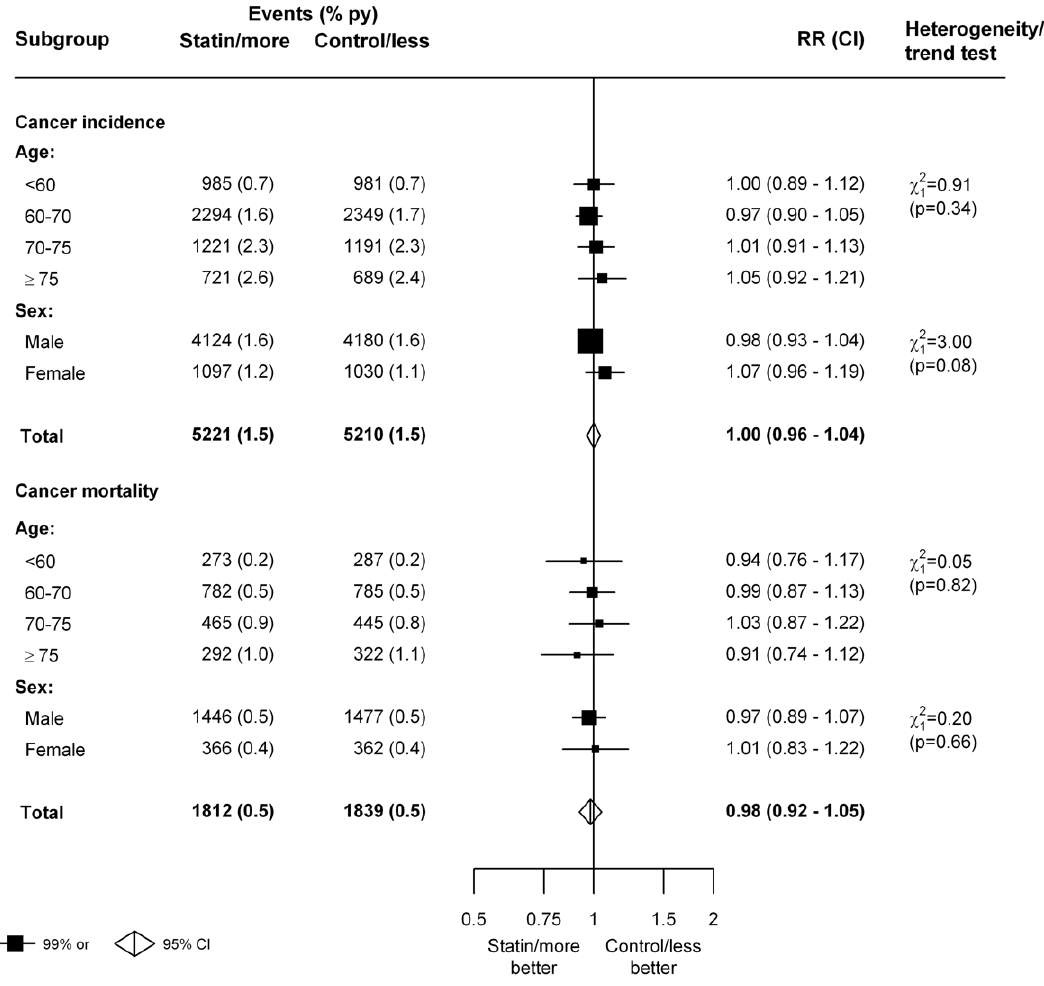
Figure 5. Effects of statin therapy on cancer incidence and mortality, by age and sex. Symbols and conventions as in Figure 1.